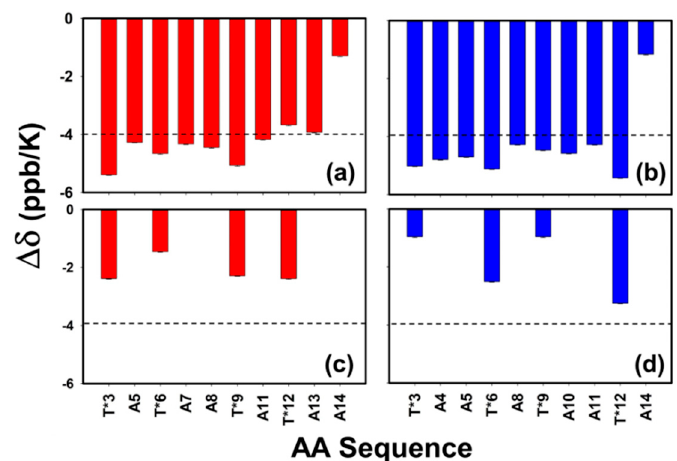
Figure 8. Amide proton temperature coe ffi cients. Panels ( a , b ) correspond to the backbone amides of AFGP8-BS and AFGP8-TB, respectively. Panels ( c , d ) correspond to the side-chain amides of AFGP8-BS and AFGP8-TB, respectively. The horizontal dashed lines at the temperature coe ffi cient of − 4.00 ppm / ◦ C suggests the cuto ff for potential molecular hydrogen bonding formation.